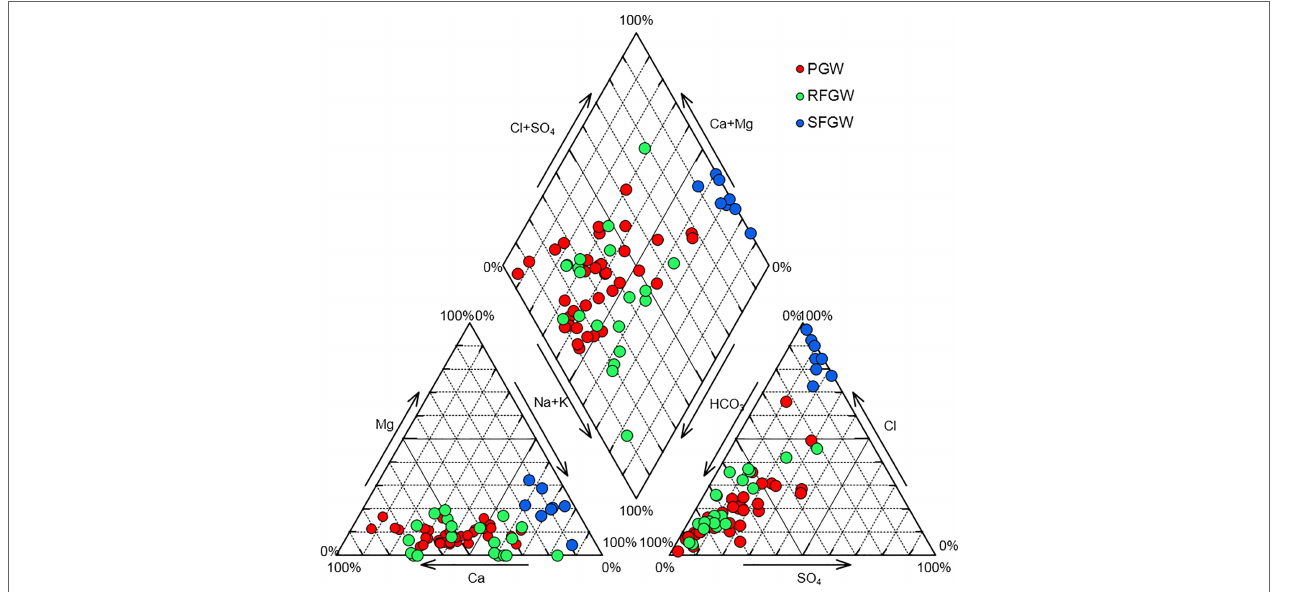
FIGURE 2 | Piper Plot of groundwater samples in the study area.